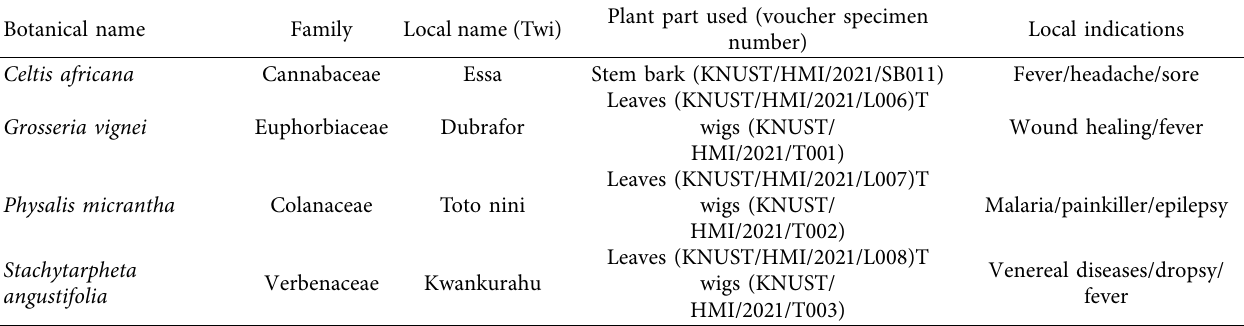
Table 1: Botanical name, family, local name, part used, and local indication of selected